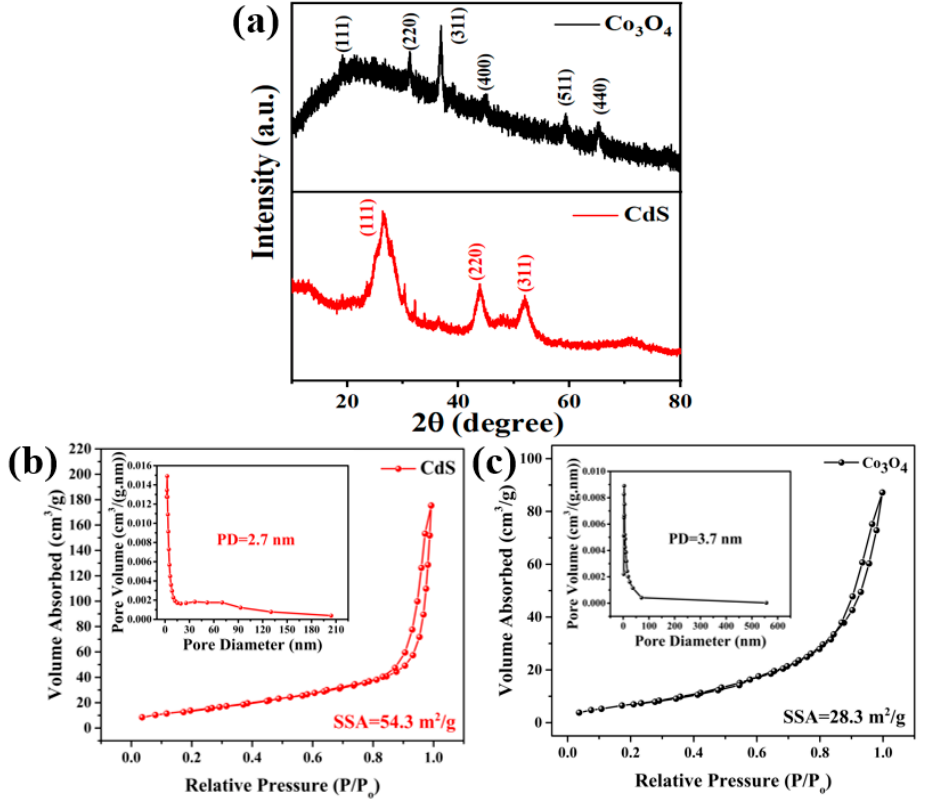
Figure 2. ( a ) XRD spectra of CdS and Co 3 O 4 nanoparticles; specific surface area with inset displaying pore size distribution of ( b ) CdS and ( c ) Co 3 O 4.